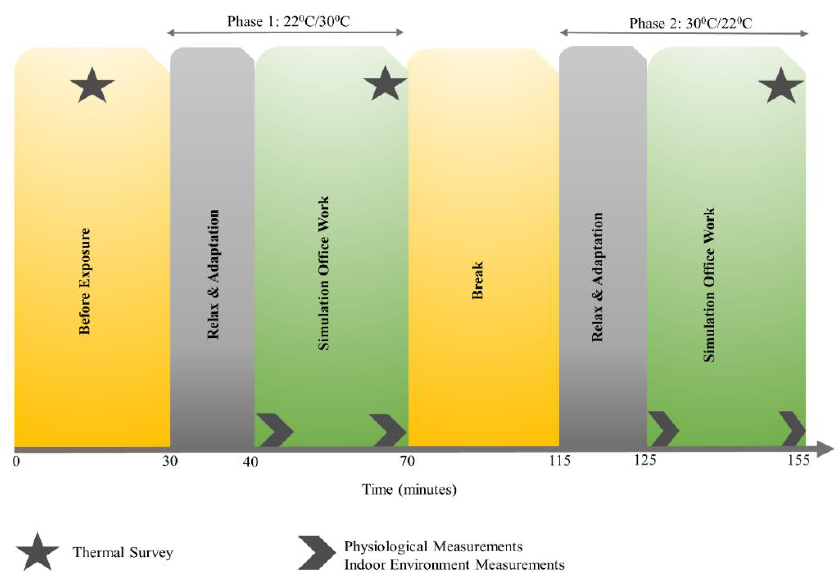
Figure 1. Illustration of experiment timeline.